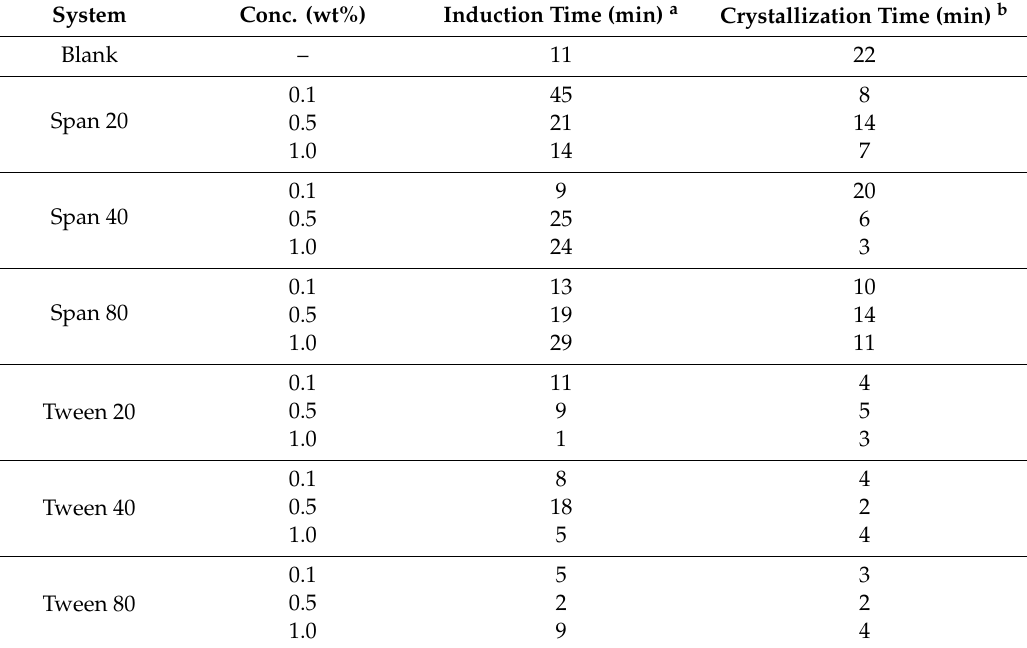
Figure 6. The e ff ect of Span 80 concentration (% v / v in oil) on cyclopentane hydrate slurry (CP / H 2 O: Figure 6. The effect of Span 80 concentration (% v/v in oil) on cyclopentane hydrate slurry (CP/H 2 O: 50 / 50; aging temperature 2 ◦ C). 50/50; aging temperature 2 °C). Table 2. Measured hydrate induction time and crystallization